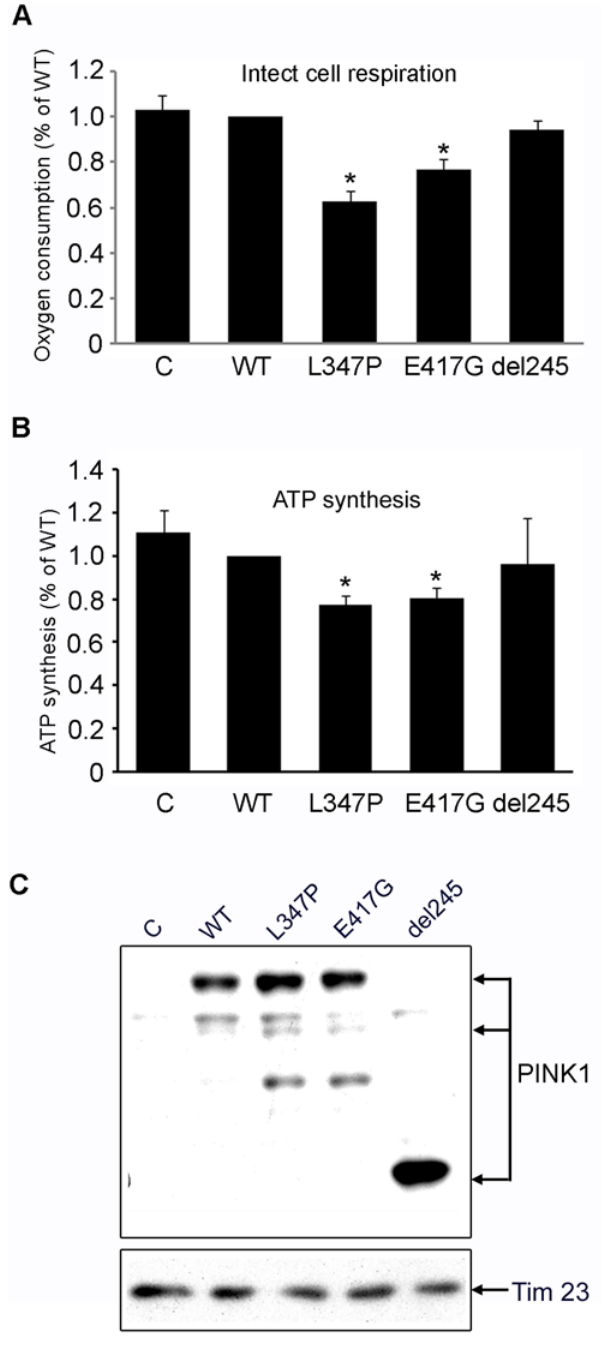
Figure 5. Mutant PINK1 impairs mitochondrial respiration and ATP synthesis in cultured SH-SY5Y cells. A) Oxygraphic measure- ment of SH-SY5Y cells infected with adenovirus of wild type (WT) PINK1, L347P-PINK1, and Del 245 PINK1. Normal respiration was measured with pyruvate as a substrate in non-infected SH-SY5Y control (C), cells infected with WT, L347P, E417G or Del 245 PINK1. A statistically significant deficit in oxygen consumption was detected in cells expressing L347P-PINK1 compared to wild type PINK1 (37.7% reduction; n=3, p , 0.01, ANOVA) or to non-infected control cells (39.3% reduction; n=3, p , 0.01, ANOVA). In cells expressing E417G-PINK1, oxygen consumption was significantly reduced compared to cells expressing wild type PINK1 (23.1% reduction, n=3, p , 0.05, ANOVA) or to non- infected cells (25.2% reduction, n=3, p , 0.05, ANOVA). There is no significant difference in respiration changes between cells